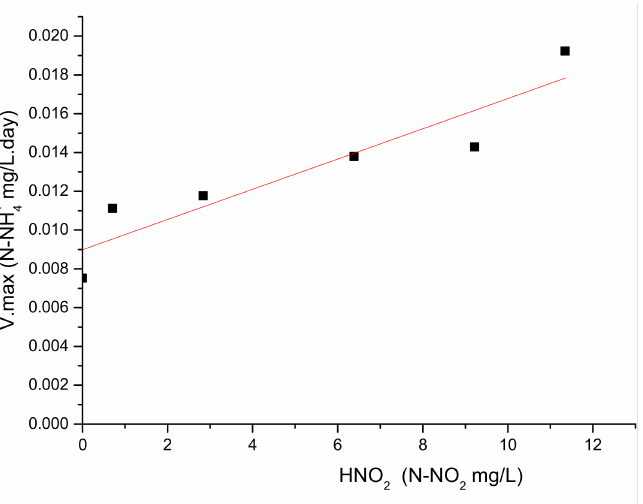
Figure 3. Competitive inhibition by HNO 2